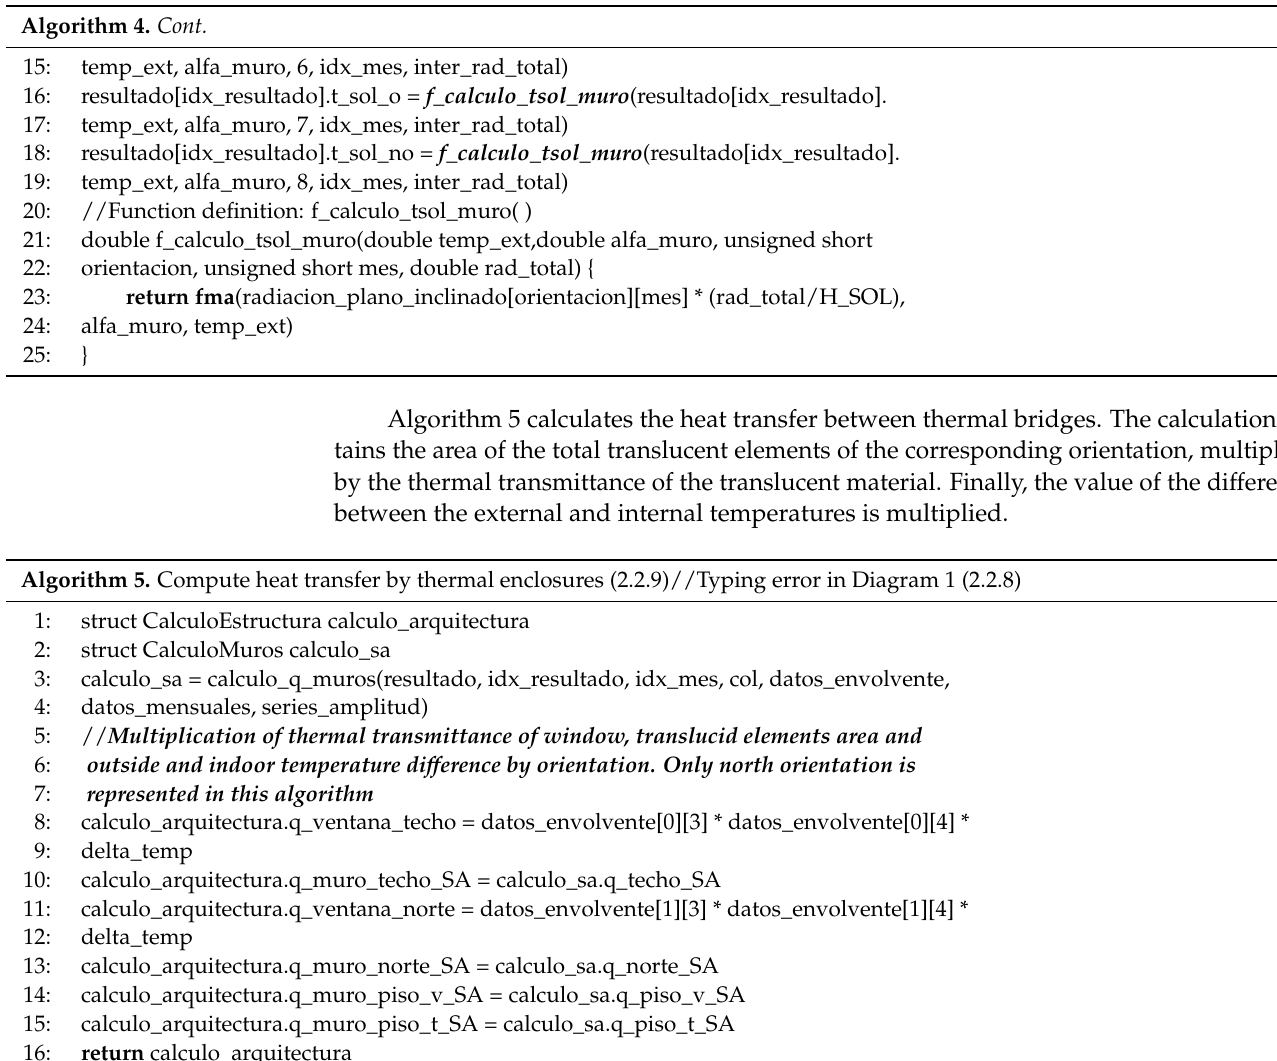
Algorithm 6 calculates the heat transfers of the different opaque elements (the walls of